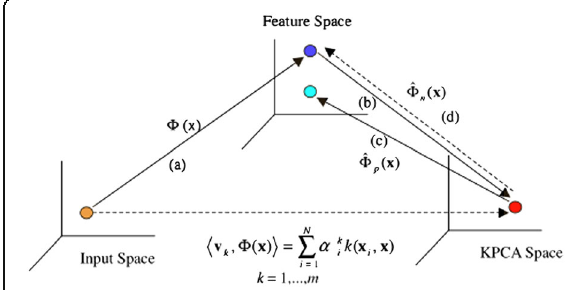
Fig. 1 The conceptual framework of the kernel principal component analysis (KPCA)